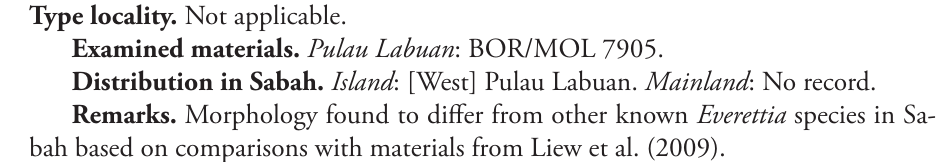
Type locality. Not applicable.